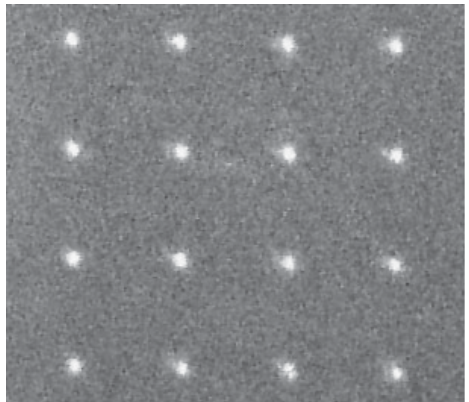
Figure 6. Hartmann-Shack image obtained with our instrument for an artificial mechanical eye cali- brated with no aberration (zero diopter),